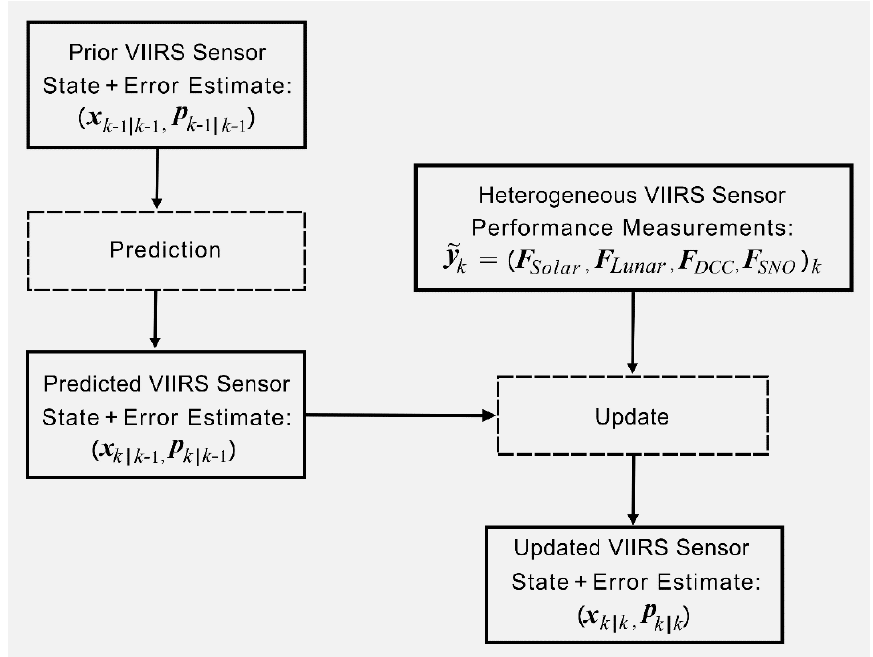
Figure 5. Schematics of KFCDF process for SNPP VIIRS data recalibration.